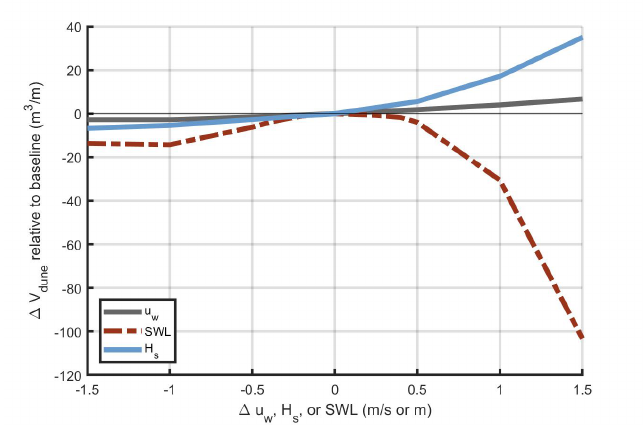
Figure 10. Sensitivity of ∆ V dune to uniform changes to the environmental time series of u w (light blue), SWL (dotted red), and H s (grey). Positive numbers indicate that more dune growth was predicted relative to the baseline (calibrated) model simulation of 17.7 m 3